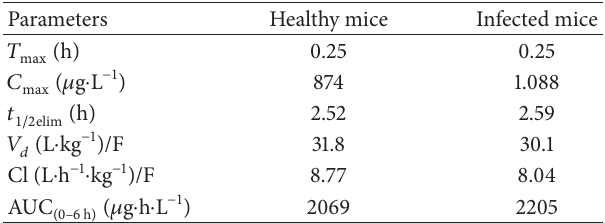
Table 2: Pharmacokinetics parameters in healthy and Plasmodium berghei ANKA infected female BALB/c mice after a single intraperi- toneal administration of cepharanthine at the dose of 21 mg/kg bodyweight